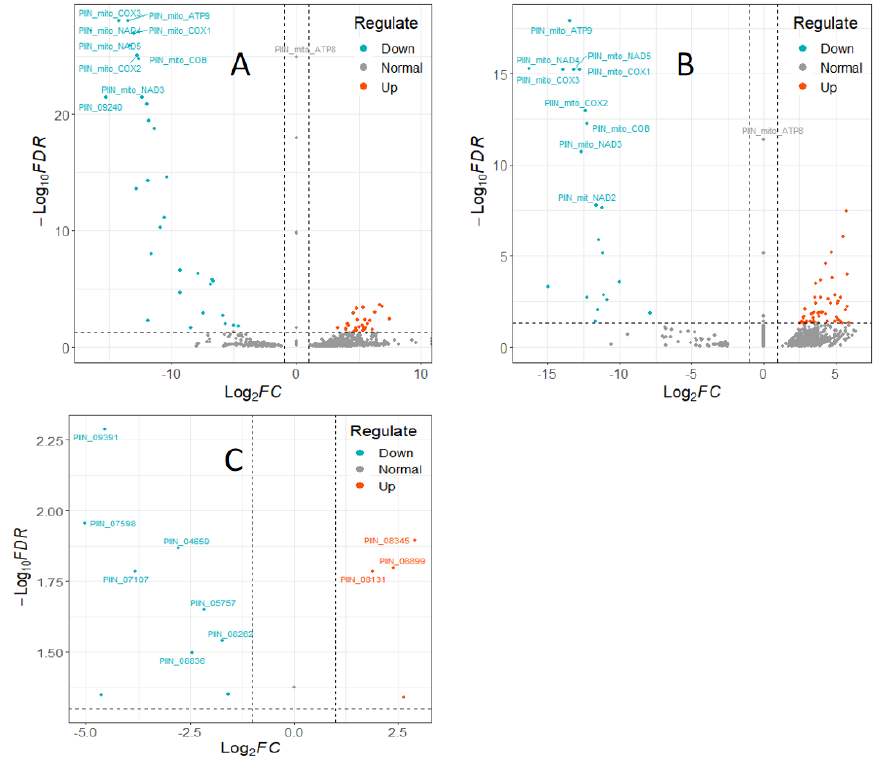
Figure 3. Volcano plots of colonization-associated, differentially expressed genes (DEGs) in P. indica. ( A ) DEGs in P. indica identified by comparing reads from colonized roots at 3 dai vs. axenic mycelium. ( B ) DEGs in P. indica identified by comparing reads from colonized roots at 7 dai vs. axenic mycelium. ( C ) P. indica DEGs identified by comparing reads from colonized roots at 7 dai vs. 3 dai. The dashed